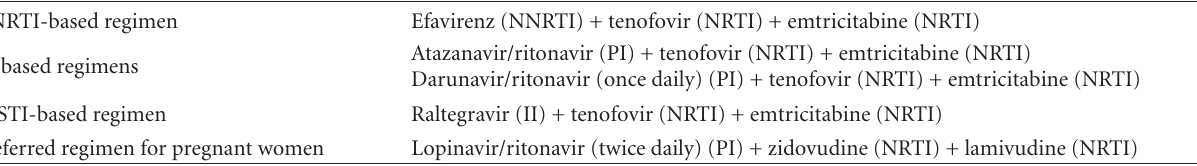
Table 1: DHHS preferred antiretroviral regimens for antiretroviral therapy-na¨ıve patients